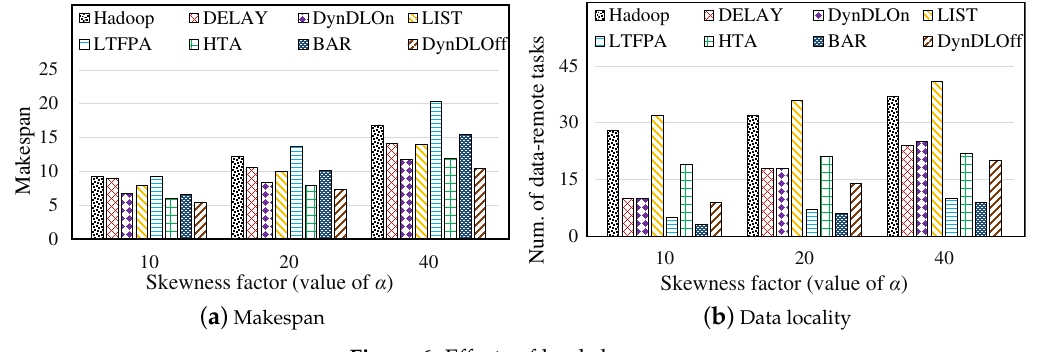
Figure 6. Effects of load skewness.